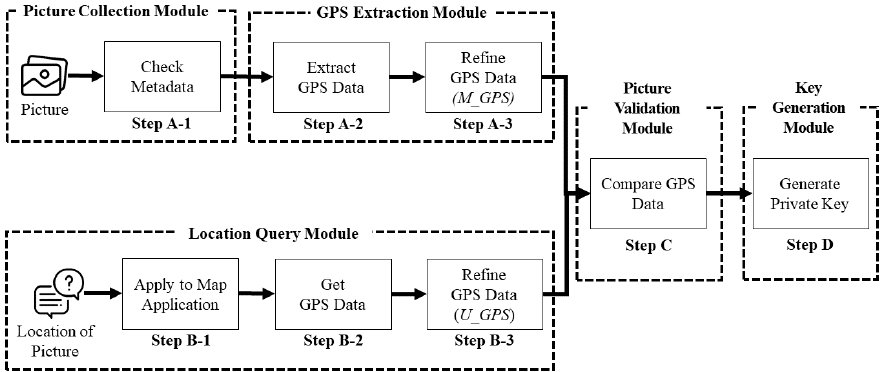
Figure 3. Private Key Generation